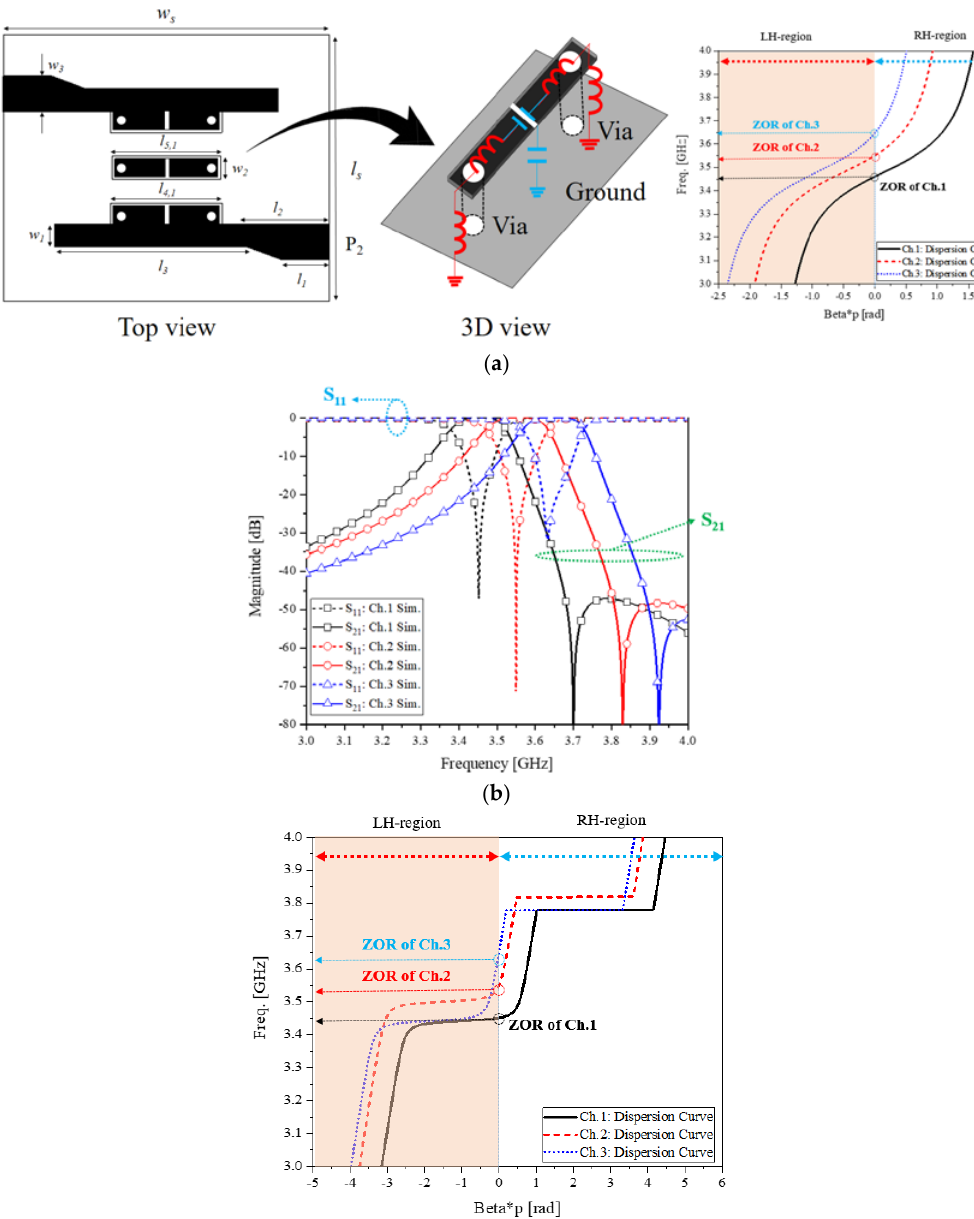
Figure 3. The metamaterial channel filter ( a ) Geometry and equivalent circuit ( b ) Frequency responses of the three bands ( c ) Dispersion diagram of the channel filters as the metamaterial property. Table 1. Geometrical parameters of the filters, multiplexers and antennas. Filters